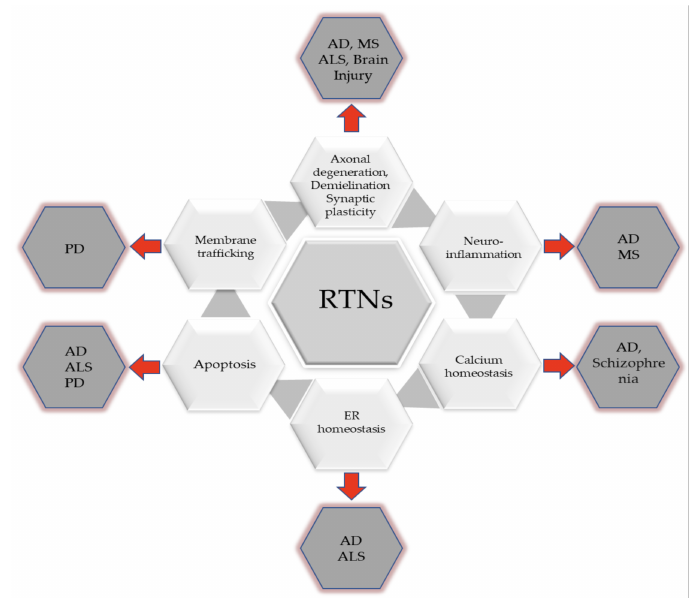
Figure 2. Involvement of RTNs in the development of neurodegenerative